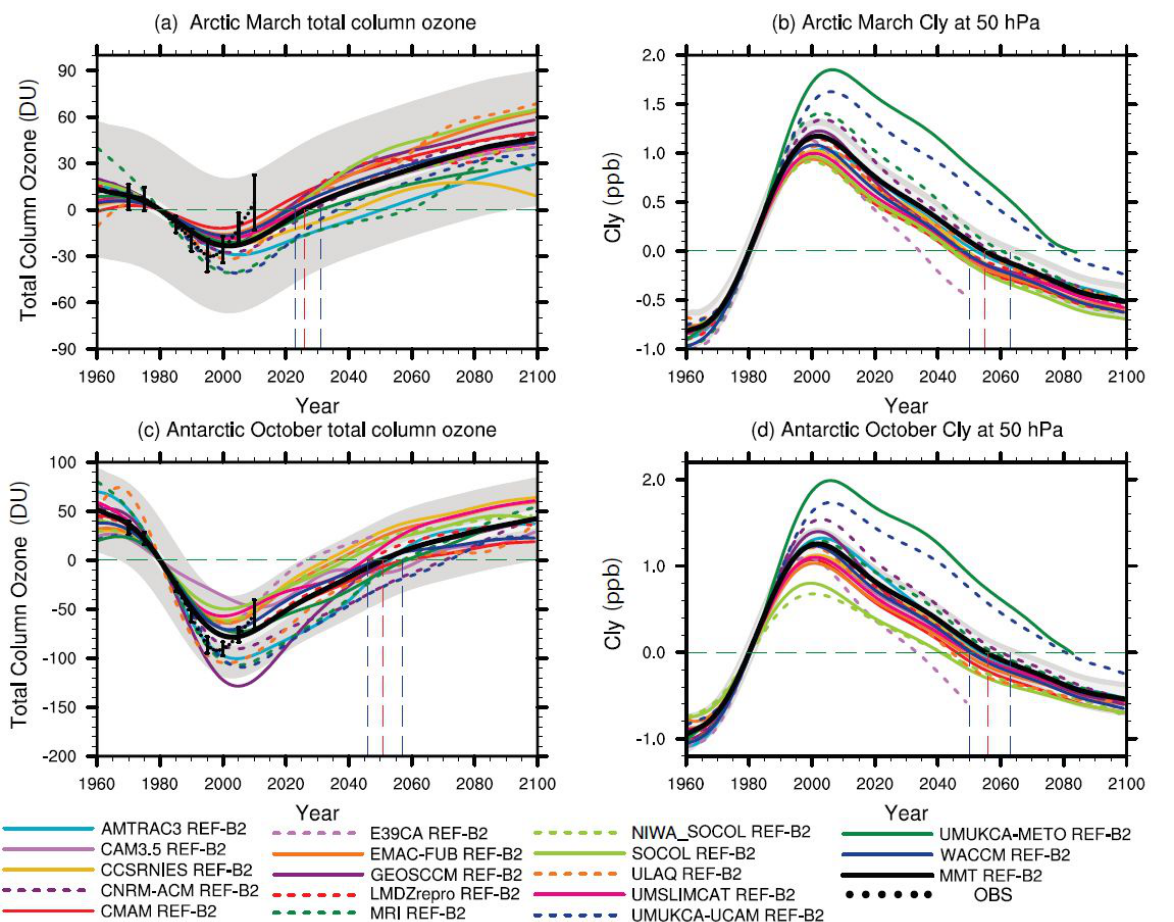
Figure 4. 1980 baseline-adjusted multi-CCM trend estimates of annually averaged total column ozone (DU; left ) and Cl at 50 hPa (ppb; right ) for Arctic (60°–90°N, upper row) y and Antarctic (60°–90°S, lower row) (thick dark gray line) with 95% confidence and 95% prediction intervals appearing as light- and dark-gray shaded regions, respectively, about the trend (note the different vertical scale among the panels). Colored lines: The baseline- adjusted individual model trends; red vertical dashed line: year when the multi-model trend in total column ozone (left) and Cl at 50 hPa (right) returns to 1980 values; blue vertical y dashed lines: uncertainty in these return dates; black dotted lines in the left panels: observed total column ozone, where a linear least square regression model was used to remove the effects of the quasi-biennial oscillation, solar cycle, El Niño-Southern Oscillation, and volcanoes from four observational data sets. The observations include ground-based measurements (updated from [47]), merged satellite data [48], the National Institute of Water and Atmospheric Research (NIWA) combined total column ozone database [49], and Solar Backscatter Ultraviolet (SBUV, SBUV/2) retrievals (updated from [50]). The observational time series is shifted vertically so that it equals 0 in